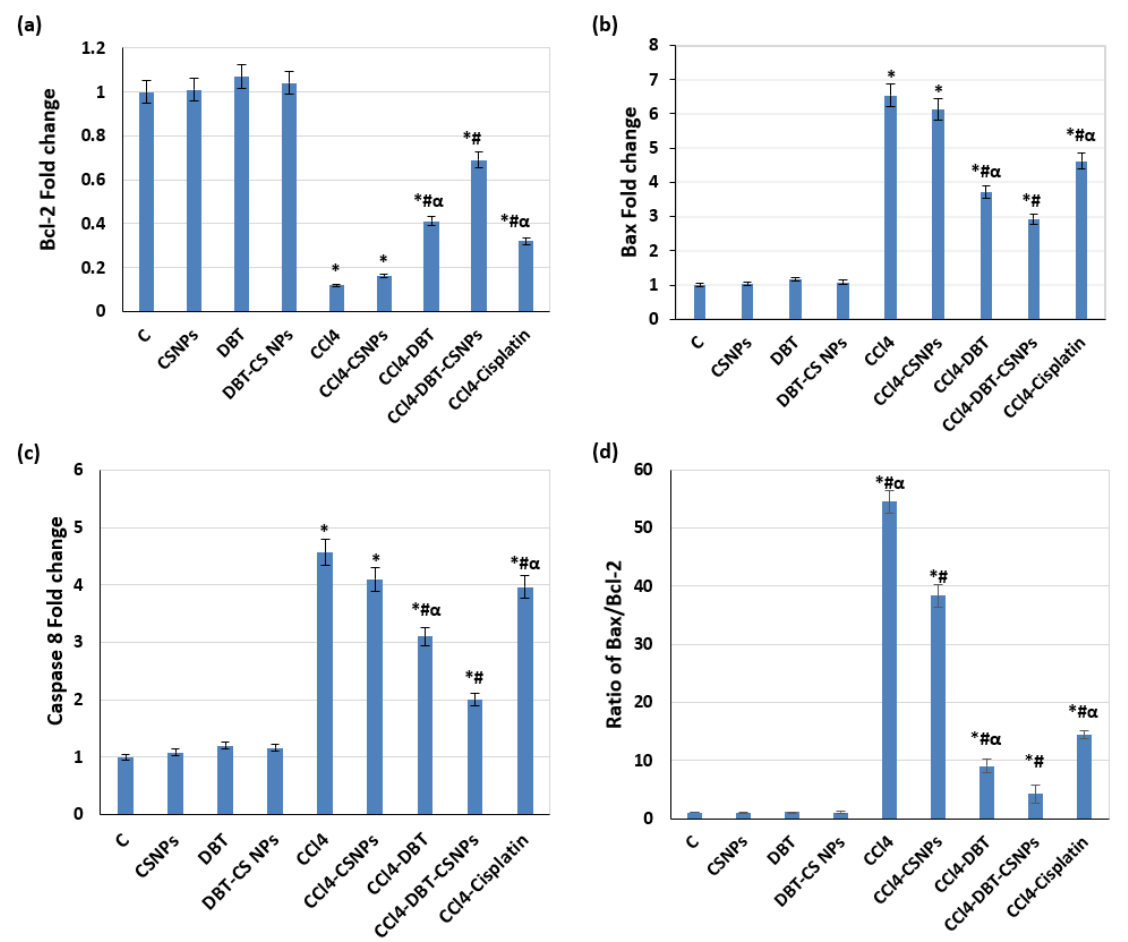
Figure 3. Effect of different compounds on apoptotic markers. ( a ) The mRNA levels of Bcl-2. ( b ) The mRNA levels of Bax. ( c ) mRNA levels of caspase-8. ( d ) Relative ratio of Bax/Bcl-2 mRNA. Gene expression was normalized to β-actin. The data are expressed as the mean ± SD of three rats. One-way analysis of variance (ANOVA) was used (* p < 0.05 versus saline control group, # p < 0.05 versus CCl 4 group & α p < 0.05 versus DBT–CSNP-treated group).